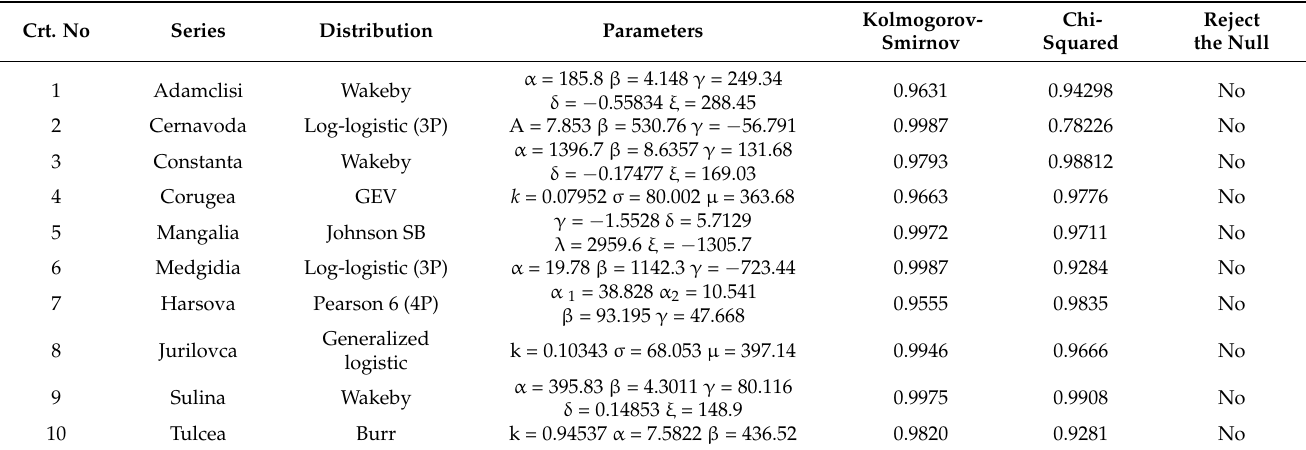
Table 1. The statistical distributions that best fit the annual precipitation series.